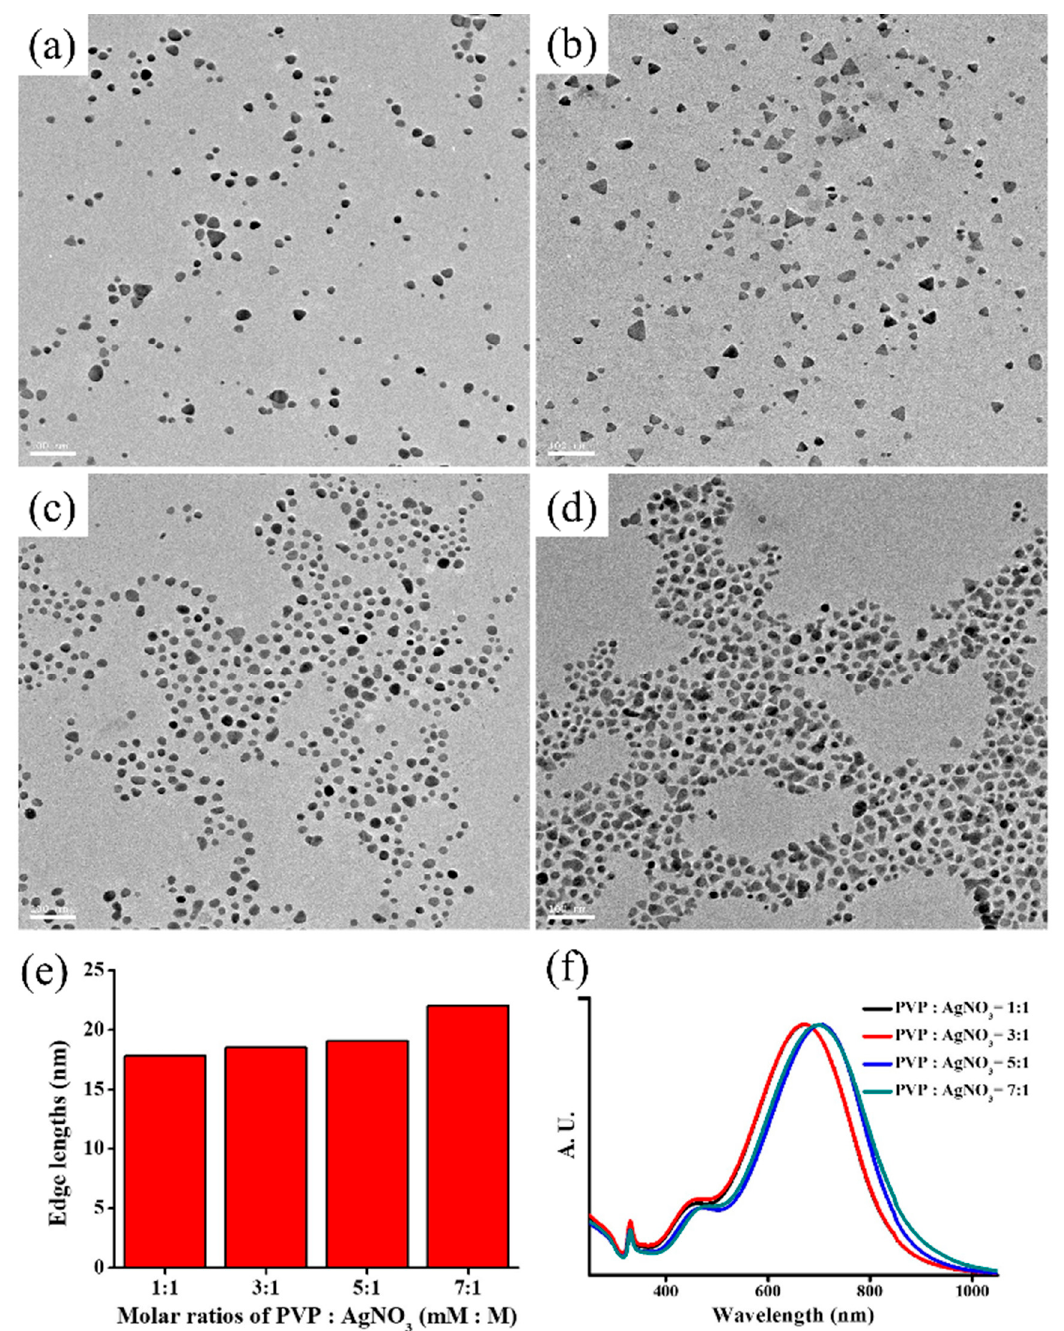
Figure 1. TEM images of silver nanoplates (AgP) prepared with various concentrations of Polyvinylpyrrolidone (PVP). The molar ratios of PVP–AgNO 3 were 1:1, 3:1, 5:1 and 7:1 (mM:M) ( a – d ). The scale bar for each TEM image is 100 nm. ( e ) The edge lengths of AgP as a function of the molar ratio of PVP–AgNO 3 . ( f ) The UV-Vis spectrum of AgP synthesized with different molar ratios of PVP–AgNO 3 .